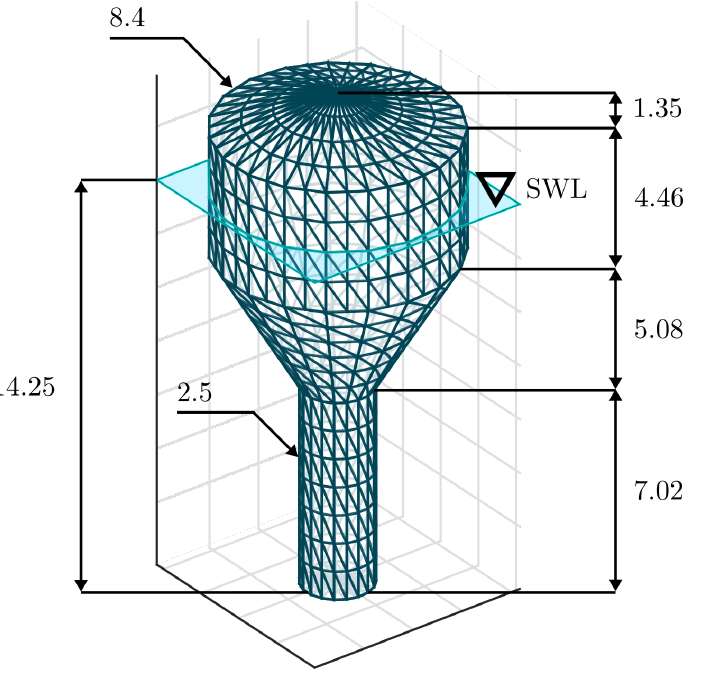
Figure 1. Schematic of the point absorber device under study. Dimensions are presented in metres. Note that the acronym SWL denotes the still water